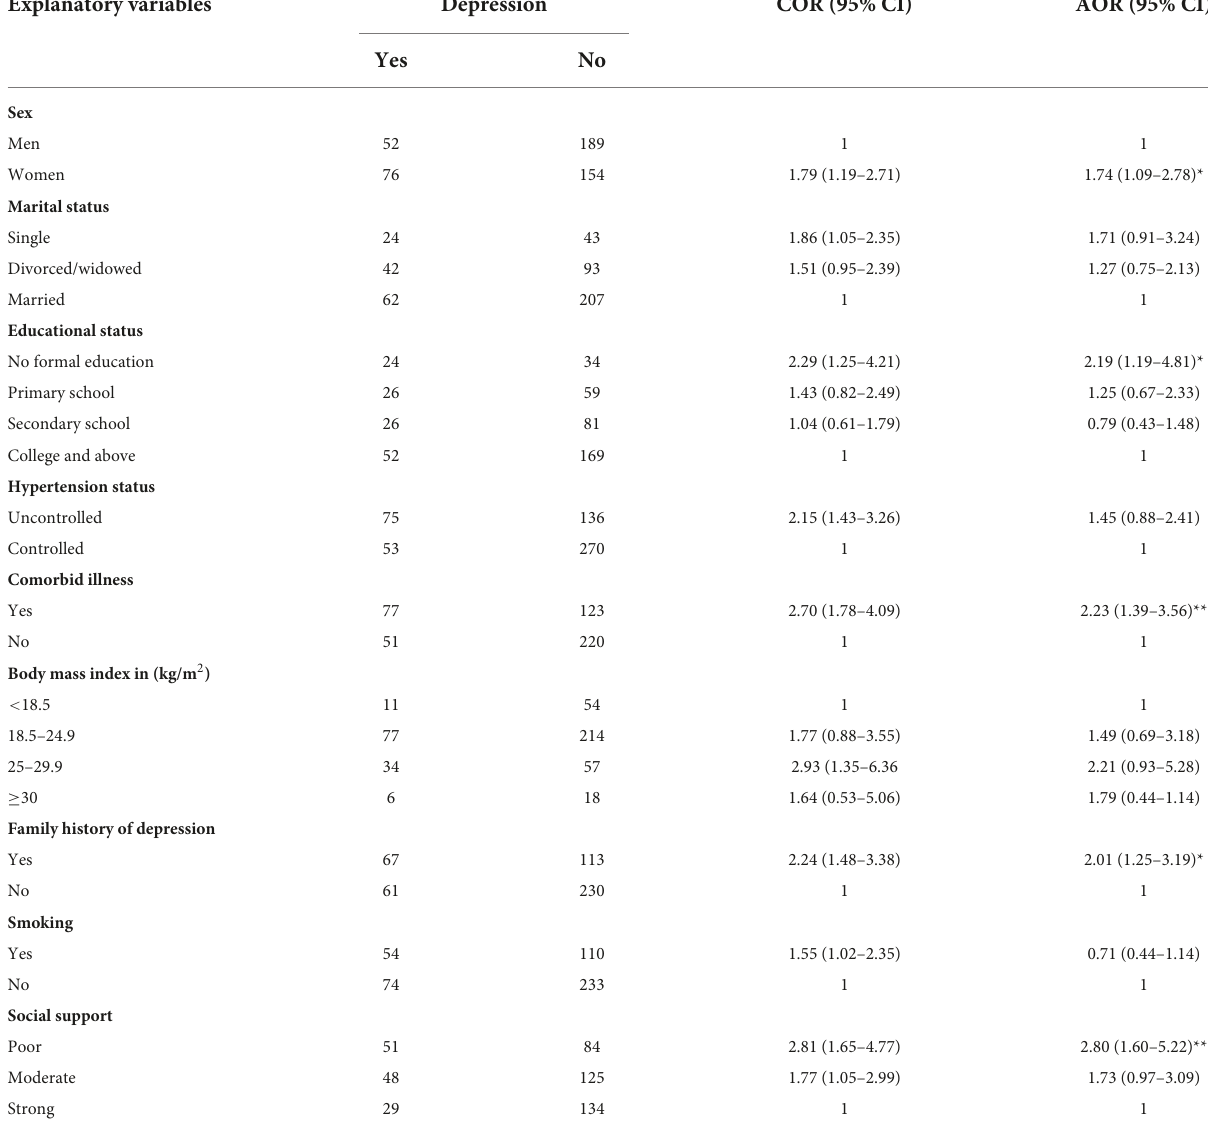
TABLE 3 Factors associated with depressive symptoms in people with hypertension on follow-up in Eastern Ethiopia ( n = 471). Explanatory